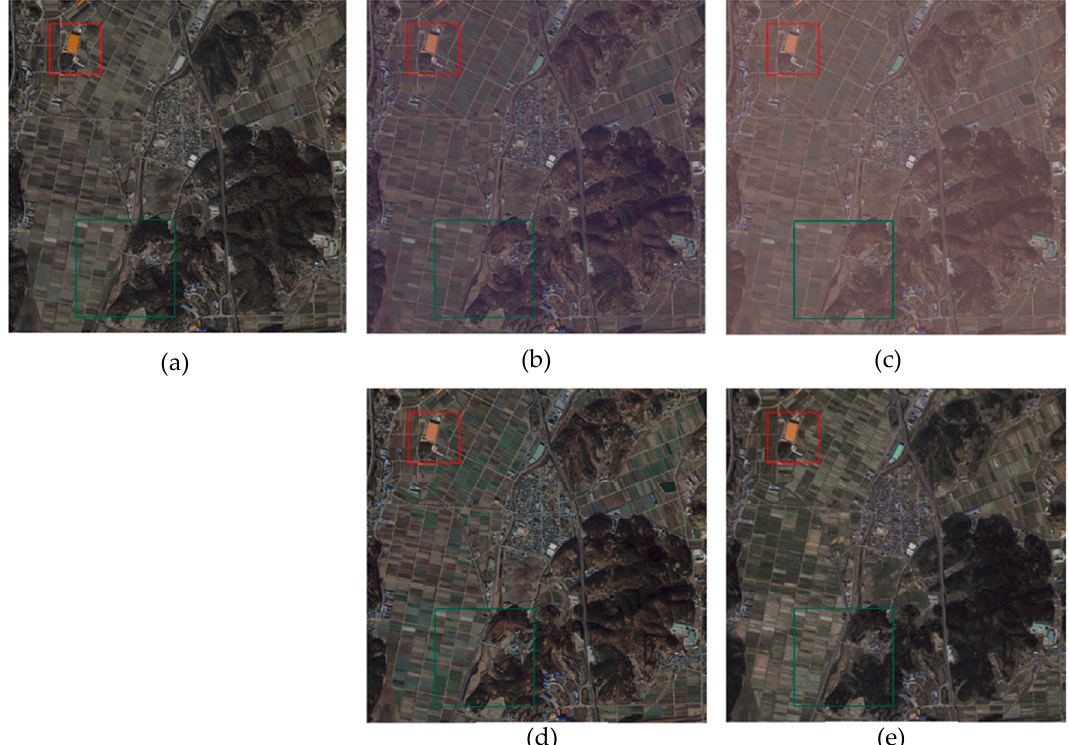
Figure 7. Comparison with the results of relative radiometric normalization for site 2: (a) proposed